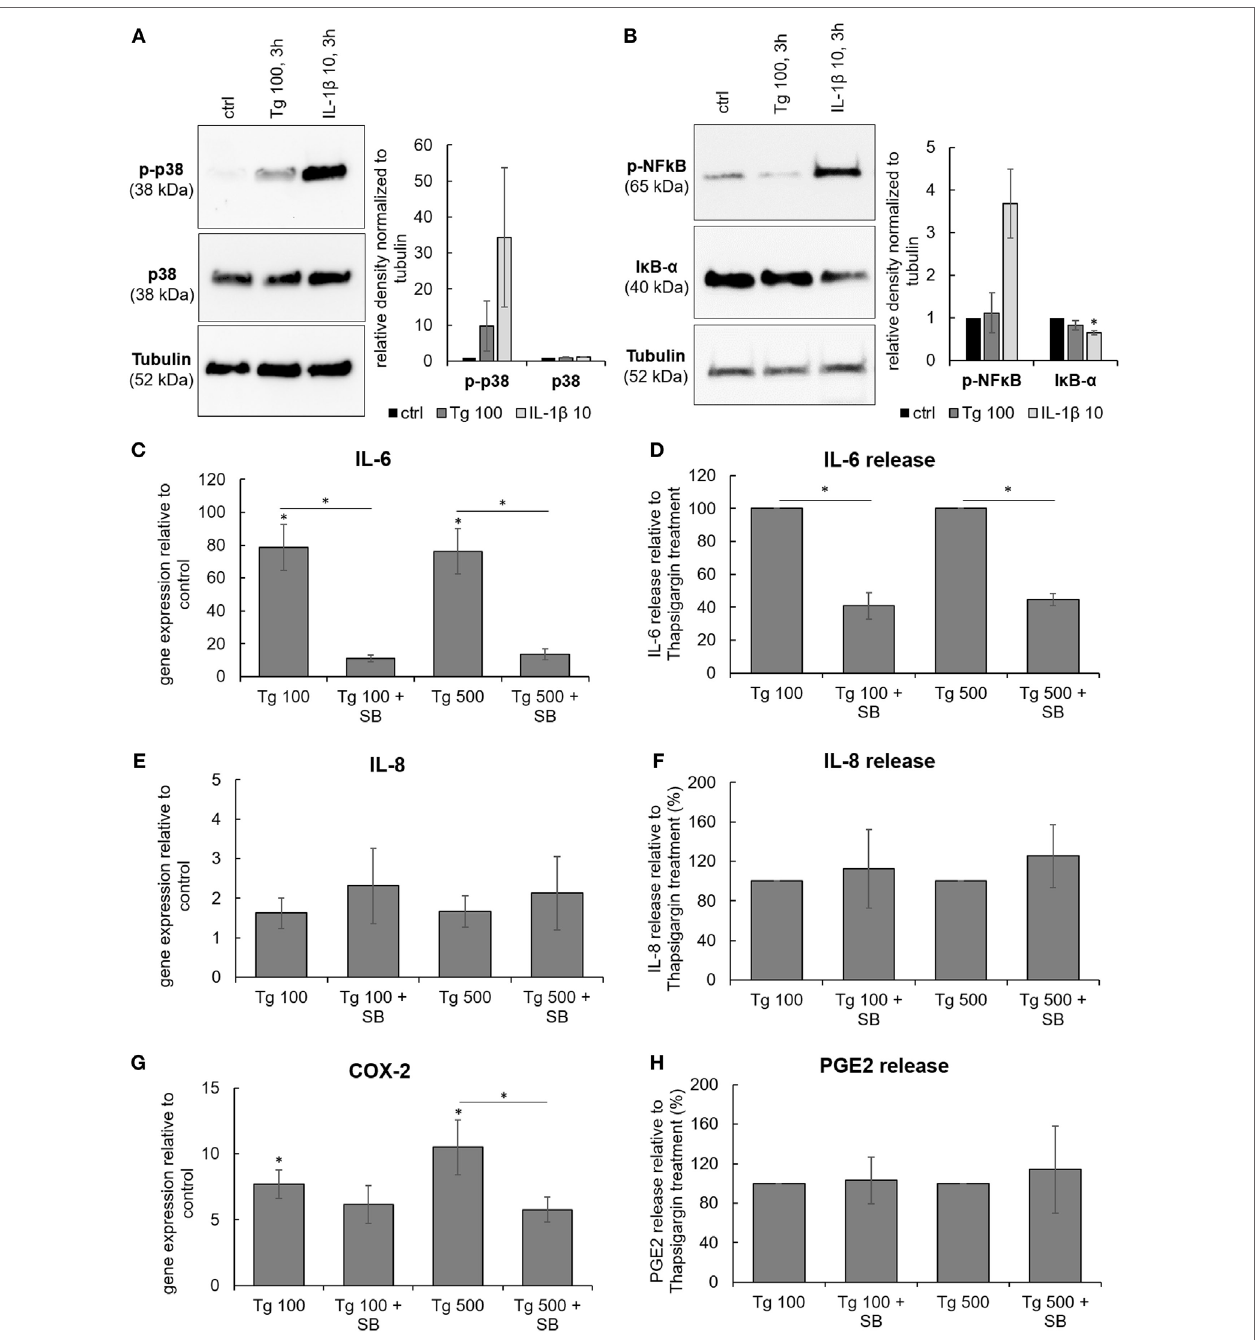
FigUre 4 | The involvement of p38 MAPK in the expression and release of IL-6, IL-8, and PGE2. Cells were isolated from degenerated lumbar intervertebral discs and treated with 100 nM thapsigargin (Tg) alone or in combination with 10 µM small molecule inhibitor of p38 SB203580 (SB). (a) 3 h treatment with Tg induced phosphorylation of p38 MAPK ( n = 4 donors). (B) NF- κ B pathway (tested by phosphorylation of NF- κ B and simultaneous degradation of IKB- α ) was not activated by 3 h treatment with Tg ( n = 4 donors). (c,e,g) Combination of Tg and SB reduced gene expression of IL-6, and COX2, but not IL-8 ( n = 4 donors). (D,F,h) SB reduced protein release of IL-6, but not IL-8 and PGE2 ( n = 4 donors). IL-1 β (10 ng/mL) was used as a positive control for immunoblotting. Data are presented as mean ± SEM, * p < 0.05 (ANOVA with Tukey post hoc